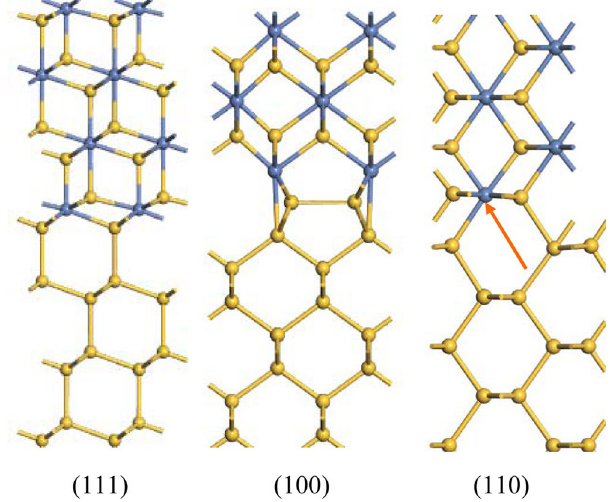
Figure 1. The atomic structure of (111), (100), and (110) Si/NiSi 2